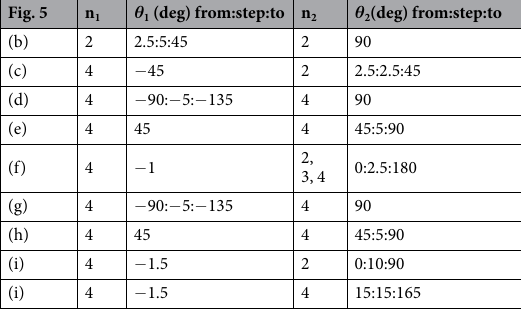
Table 1. Retardation Γ ( n ) = λ / n and orientation angle θ 1,2 parameters of the two wave plates WP 1,2 of simulations and experiments shown in Fig.